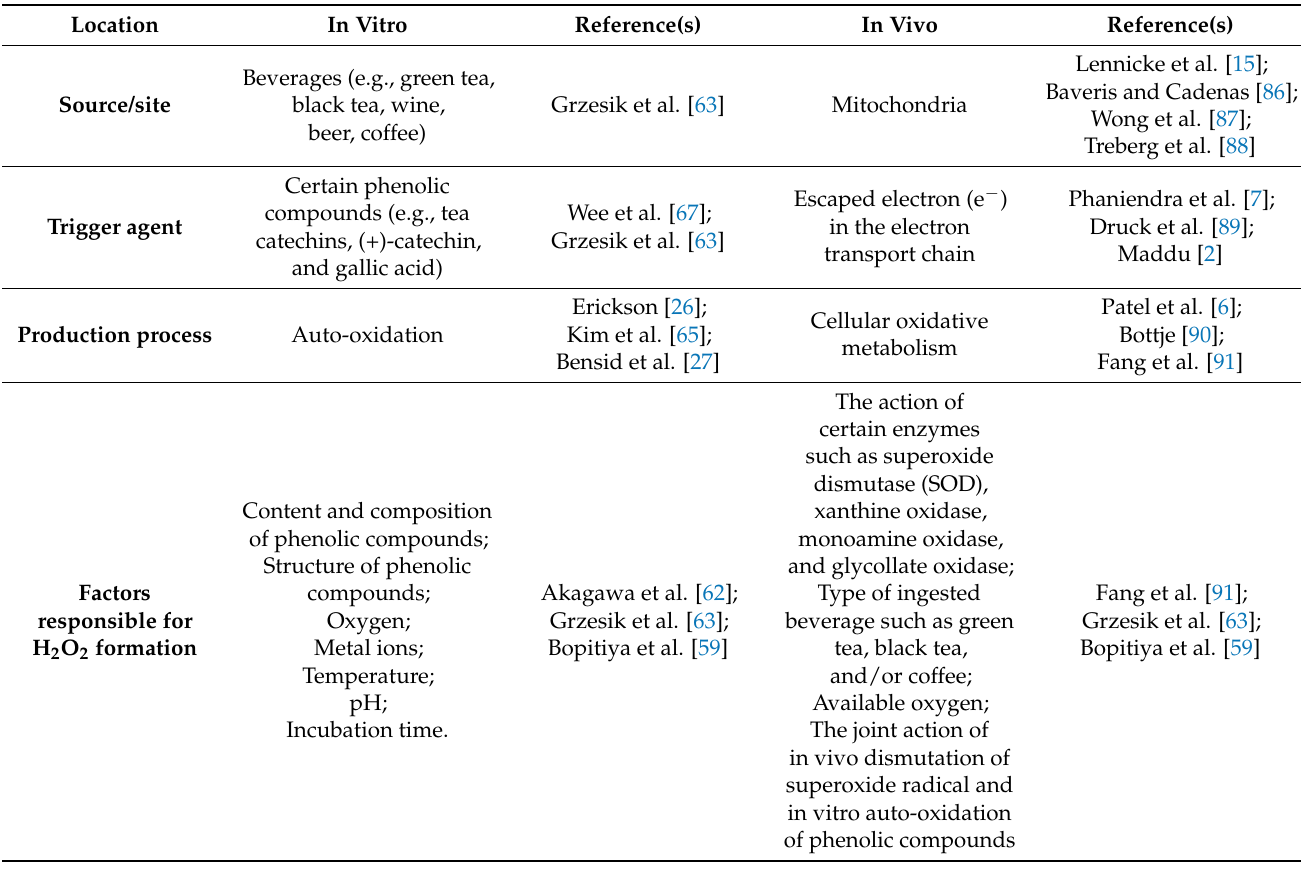
Figure 6. Schematic diagram of cholesterol oxidation and isomerization catalysed by cholesterol oxidase (Source: Adányi et al. [85]). Table 1. Some key situations associated with the formation of H 2 O 2